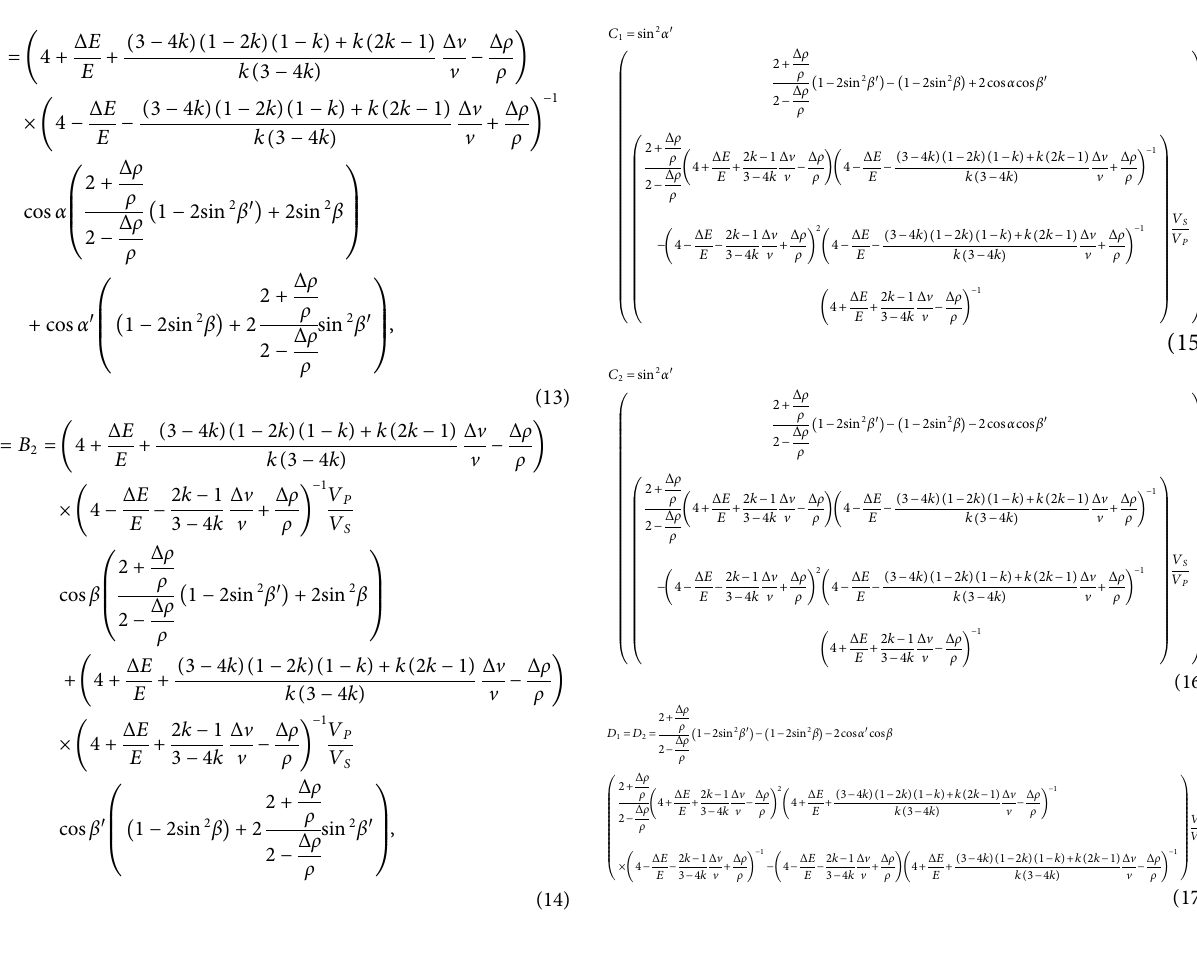
Frontiers in Earth